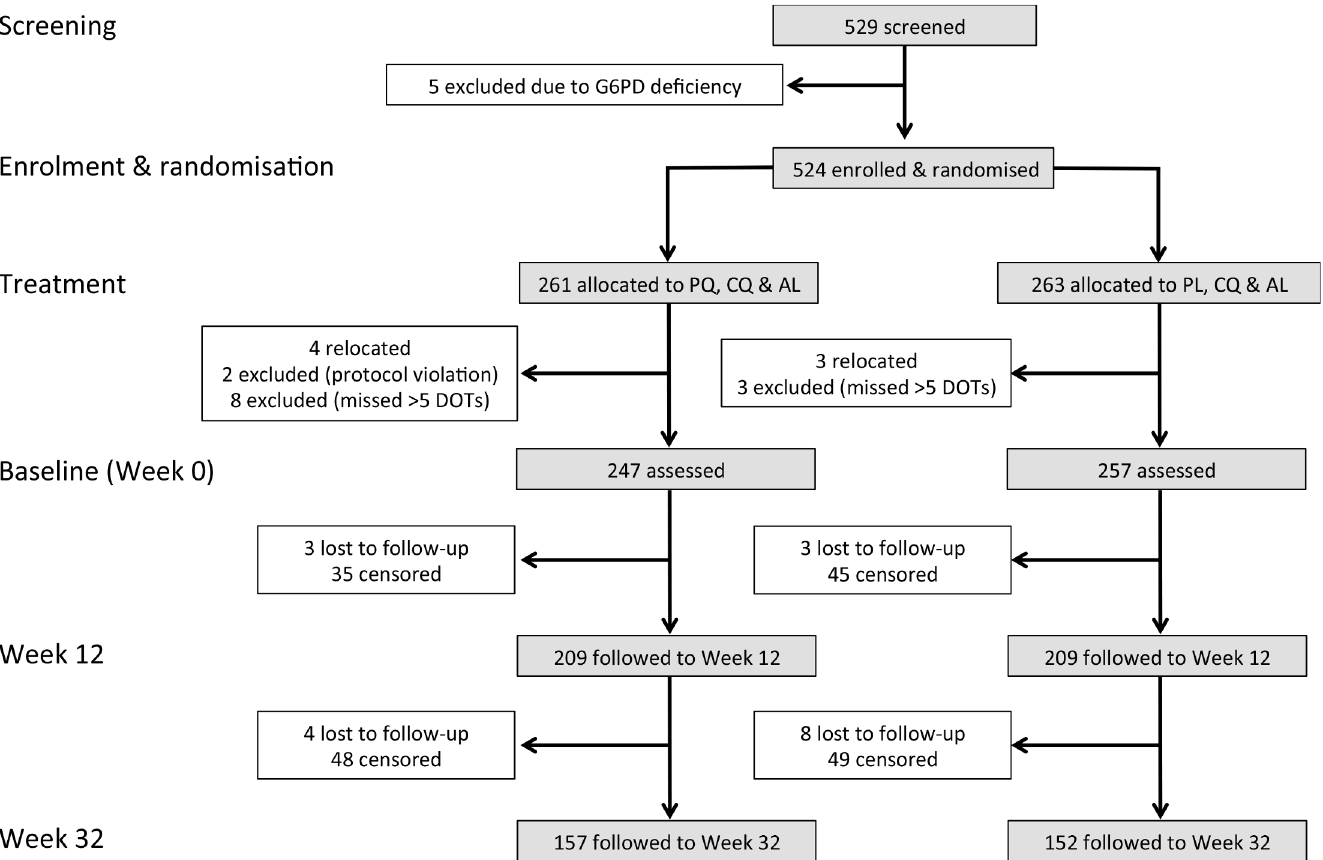
Fig 3. Consort diagram: study design, randomisation, and retention of study participants during follow-up. In the analysis of time to first infection and clinical episode, children were censored on the last day before the first of two consecutive missed clinical visits.